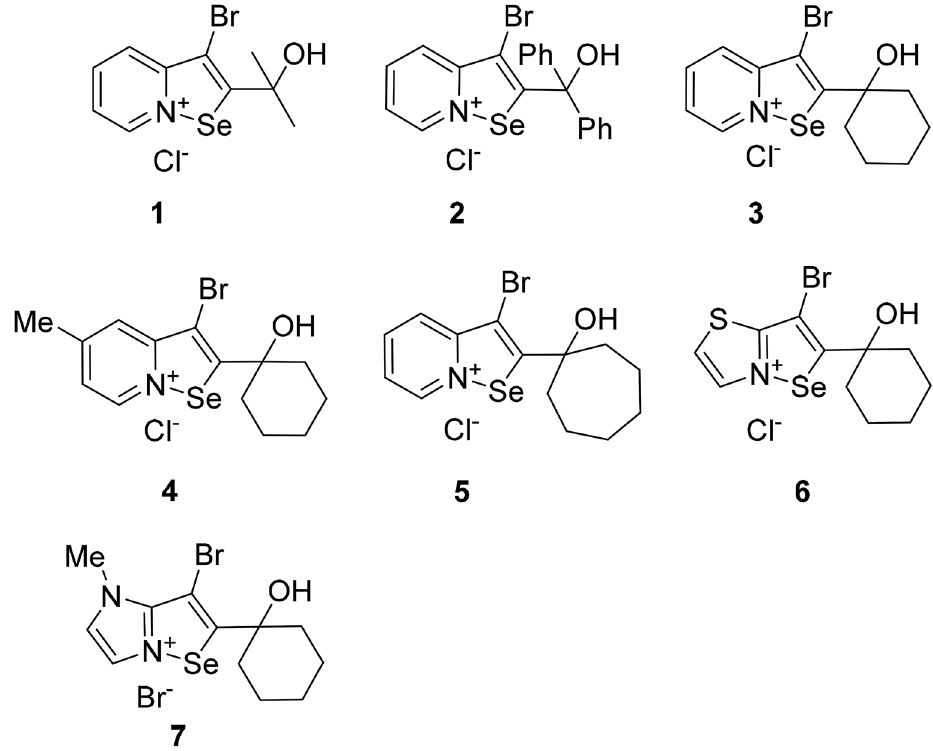
Figure 1. Tested fused isoselenazolium salts 1 – 7